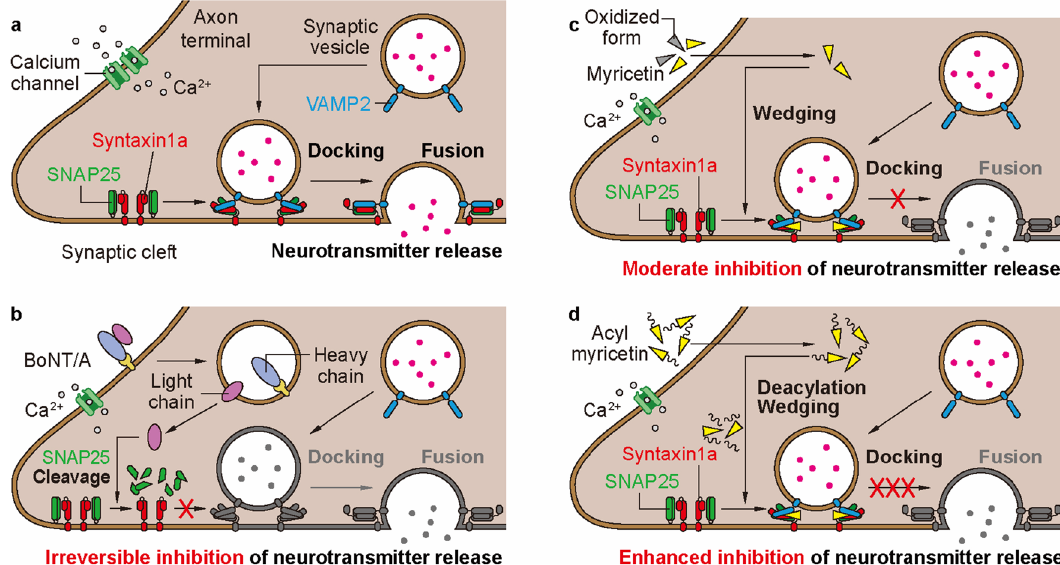
Figure 6. Proposed mechanism-of-action of acyl myricetins showing BoNT/A-like activity for inhibition of neurotransmission. ( a ) Neurotransmitter release by SNARE-mediated membrane fusion. At the axon terminal, synaptic vesicle is recruited to active zone for ‘docking’, where t-SNARE proteins on the presynaptic membrane, Syntaxin 1a and SNAP25, and v-SNARE protein VAMP2 on the synaptic vesicle form a SNARE complex. With calcium influx, membrane fusion occurs, allowing neurotransmitter to release into the synaptic cleft. ( b – d ) Inhibitory activity of acyl myricetins on neurotransmission compared to BoNT/A and parental myricetin. Unlike BoNT/A, which inhibits neurotransmission by cleaving SNAP25 after internalization into the cell ( b ), ( c ) myricetin and ( d ) its acylated derivatives intercalates and wedges into the inner layer of the SNARE complex during its zippering process, eventually leading to inhibition of neurotransmitter release. It is noteworthy that the enhanced inhibitory effect of acylated myricetin is likely due to the improved oxidation resistance and lipophilicity-based penetration property compared to myricetin ( d ). SNAP25 synaptosomal-associated protein 25 kDa, VAMP2 vesicle-associated membrane protein 2, BoNT/A botulinum neurotoxin